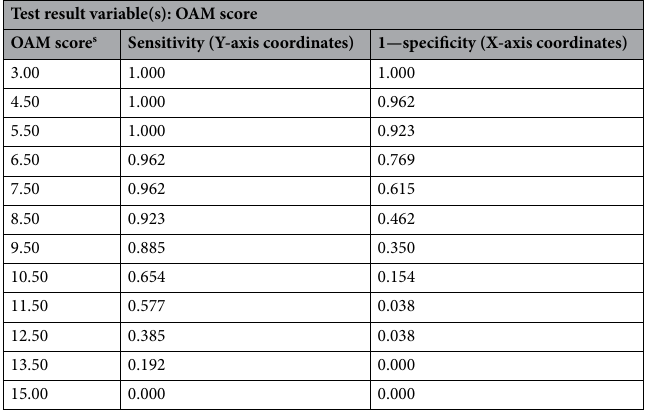
Table 8. Sensitivity and 1-specificity values at different AMS, calculated based on the ROC curve (Coordinates of the curve) in GP-GC kinship analysis by autosomal STR. a The smallest cutoff value is the minimum observed test value minus 1, and the largest cutoff value is the maximum observed test value plus 1. All the other cutoff values are the averages of two consecutive ordered observed test